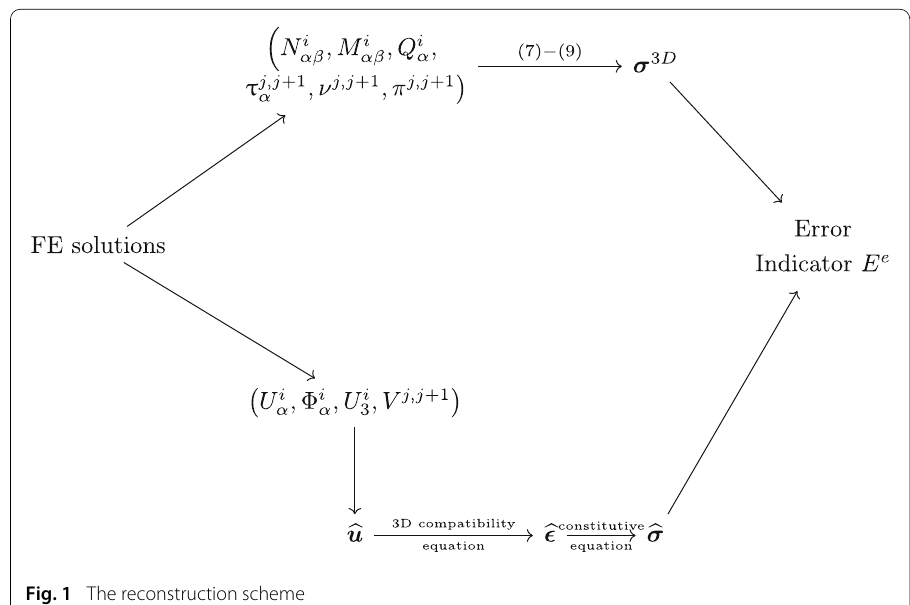
Fig. 1 The reconstruction